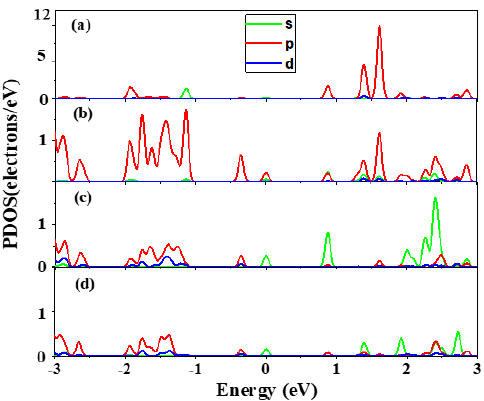
Figure 8. Partial DOSs of ( a ) Bi, ( b ) Te, ( c ) Hg, and ( d ) Cd in Bi Hg -doped Hg 0.75 Cd 0.25 Te.